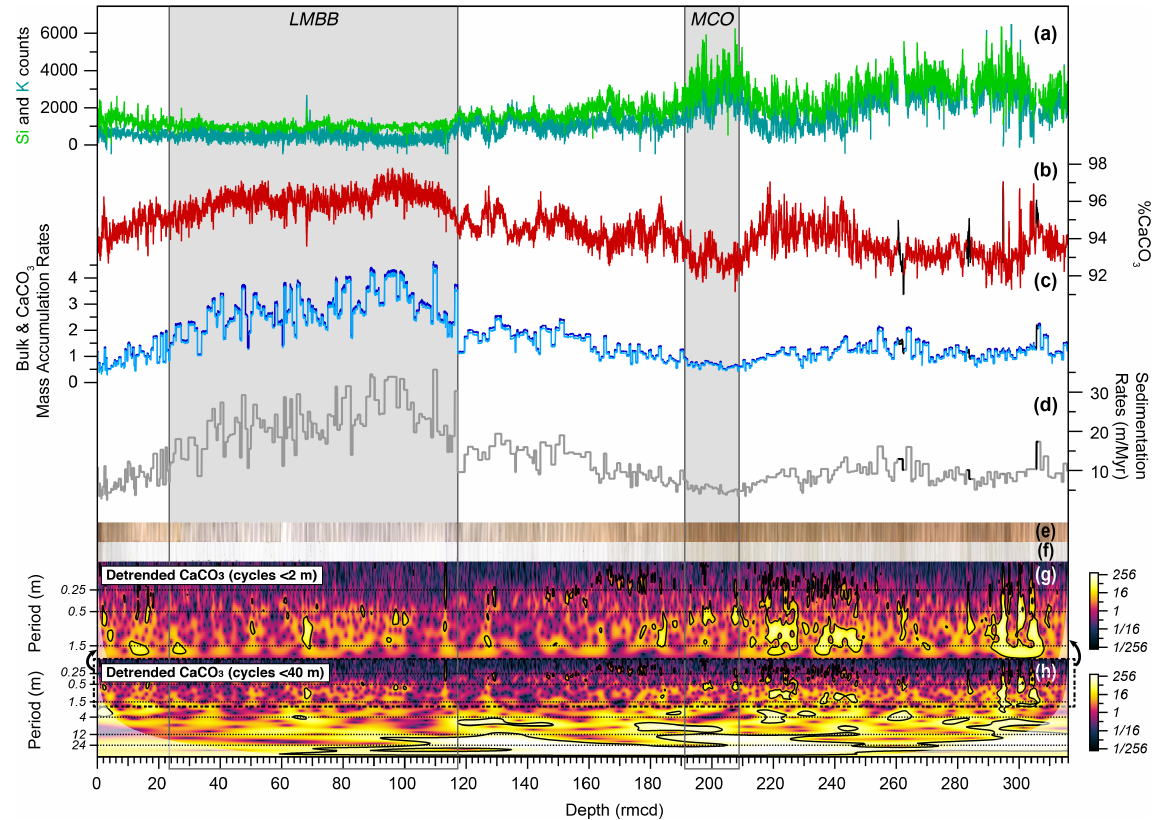
Figure 3. On the new revised composite depth (rmcd) (a) Site 1264 XRF Si (green) and K (teal) intensities, (b) %CaCO 3 data derived from ln(Ca / Fe) for Sites 1264 (dark red) and 1265 (black), (c) bulk and CaCO 3 MARs for Sites 1264 (bulk is dark blue; CaCO 3 is light blue) and 1265 (bulk is black; CaCO 3 is dark grey), (d) sedimentation rates in mMyr − 1 for Sites 1264 (light grey) and 1265 (black), and the combined composite core photo for Site 1264–1265 compiled using line scan (e) and core box photo images (f) . The depth-domain wavelet spectra are shown for the %CaCO 3 data after it was detrended to remove all cycles greater than 2m (g) or greater than 40m (h) . The periods are highlighted in metres. The wavelets were generated using the code from Torrence and Compo (1998) and Grinsted et al. (2004). The approximate stratigraphic location of the MCO and the LMBB are highlighted by shaded grey